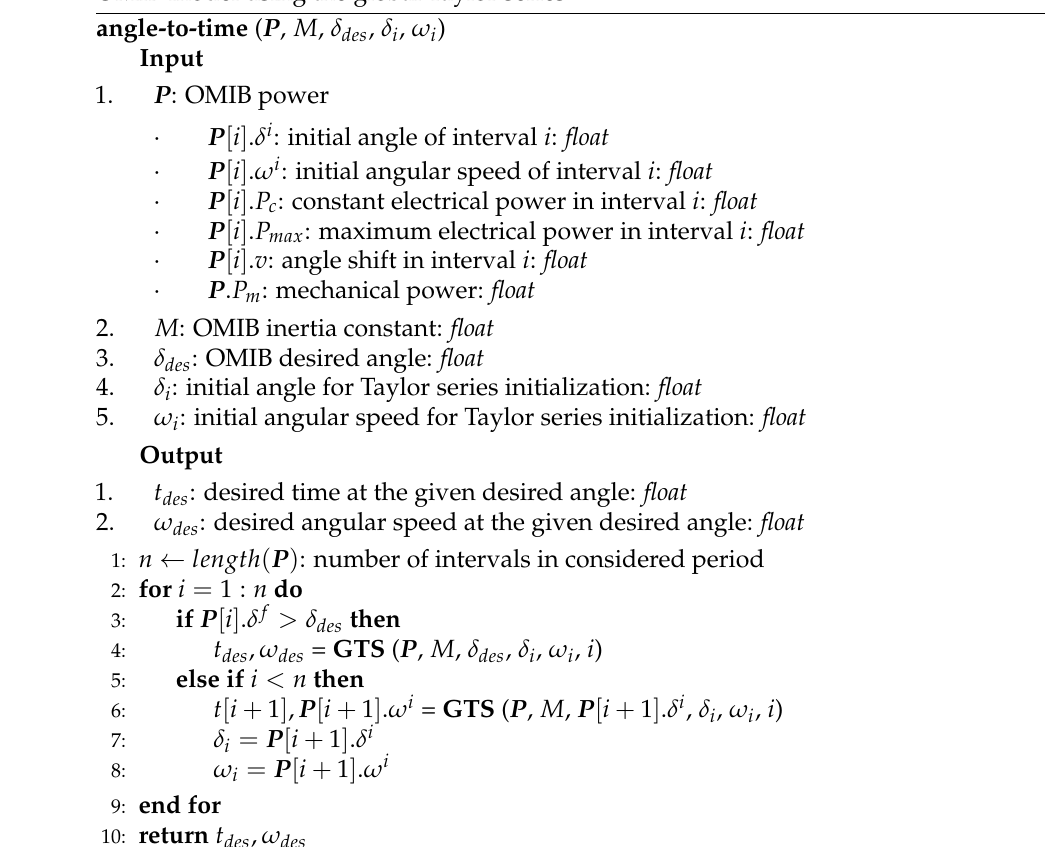
Algorithm A10 pseudocode details the function to estimate the generators’ angle trajectory in time. The function Trajectory updates the generator angles interval by interval up to a final time. This function relies on the function ITS , detailed in Algorithm A11 pseudocode, which employs Taylor series equations for each individual generator to find a desired angle and angular speed in an interval at a desired time and using the initial